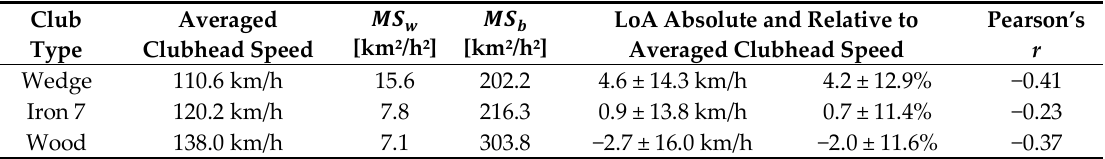
Table 1. Corresponding parameters to Figure 1 including mean variation within-subjects ( (cid:1839)(cid:1845) (cid:3050) ) and between-subjects ( (cid:1839)(cid:1845) (cid:3029) ). LoA given as absolute values and normalized to averaged clubhead speed. Correlation coefficients r given for linear model of (cid:1856) vs. clubhead